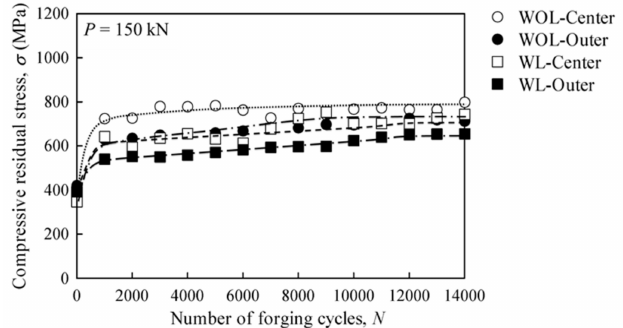
Figure 8. Compressive residual stress at the center and the average of outer areas by the number of forging cycles, for the 150 kN forging load. (WL—With Lubrication, WOL—Without Lubrication).